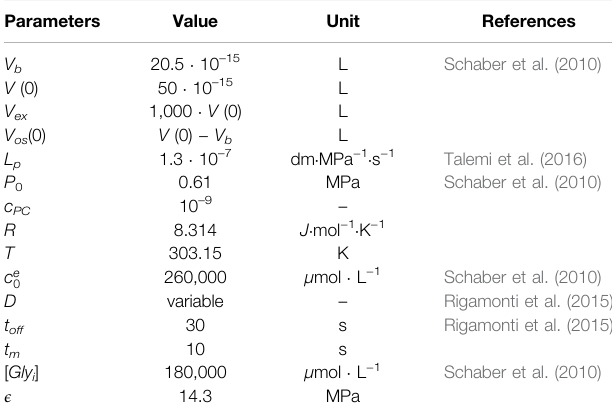
TABLE 1 | List of parameters of the biophysical module.